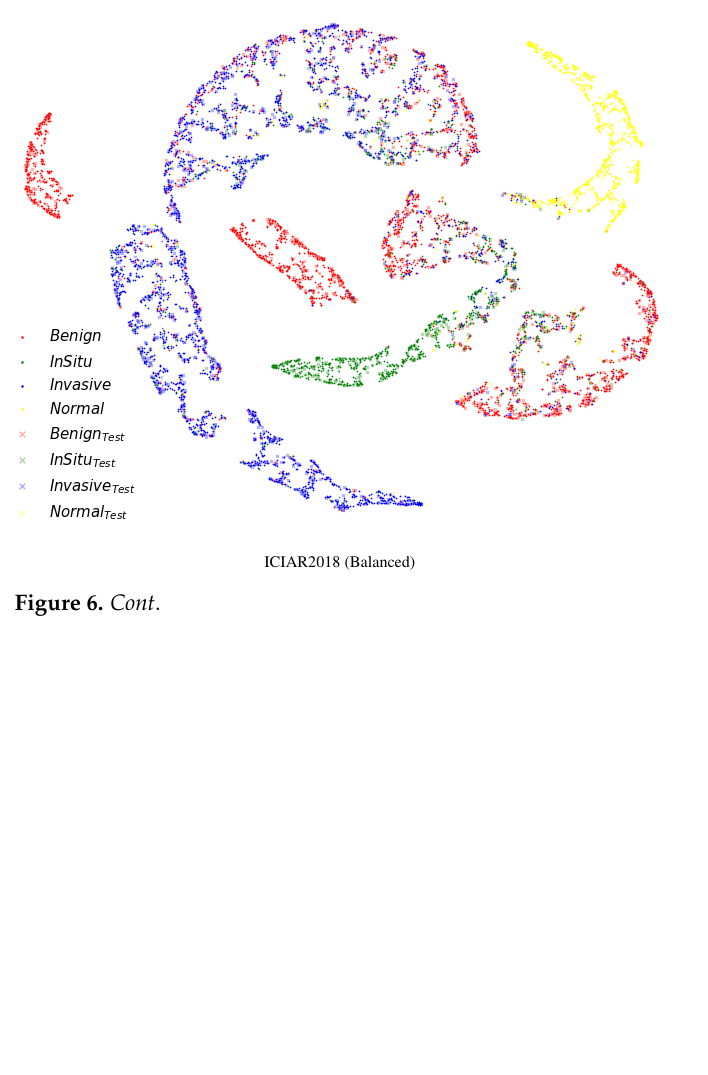
Dartmouth Figure 7. 2D visualization on two different layers using t-SNE [51] for the multi-class classification. Projection of the last fully connected layer. Cross shapes represent test samples . (Best viewed in color).